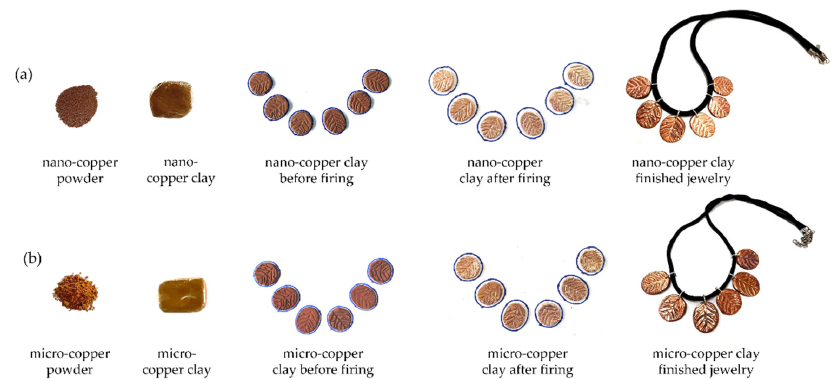
Figure 12. ( a ) Synthesized nano-copper particles (left) made into finished nano-copper clay jewelry (right); ( b ) Synthesized micro-copper particles (left) made into finished micro-copper clay jewelry (right). The blue line shows the initial size of each specimen before the firing process.